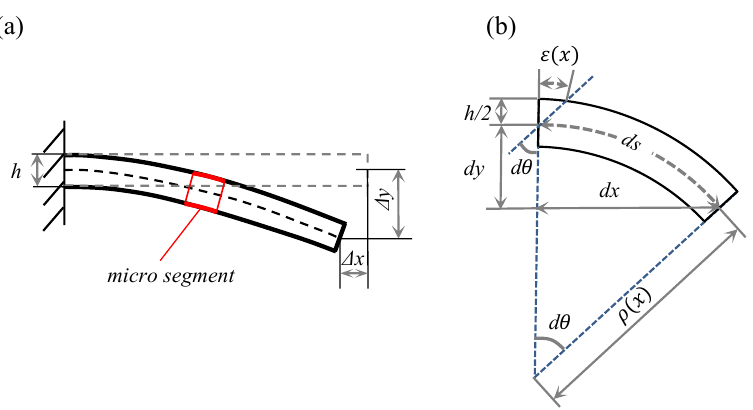
Figure 3. ( a ) The micro segment of the beam. ( b ) The relationship of the strain and